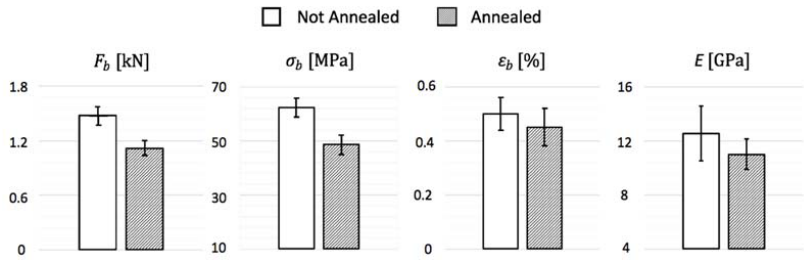
Figure 6. Comparison of bending test results.